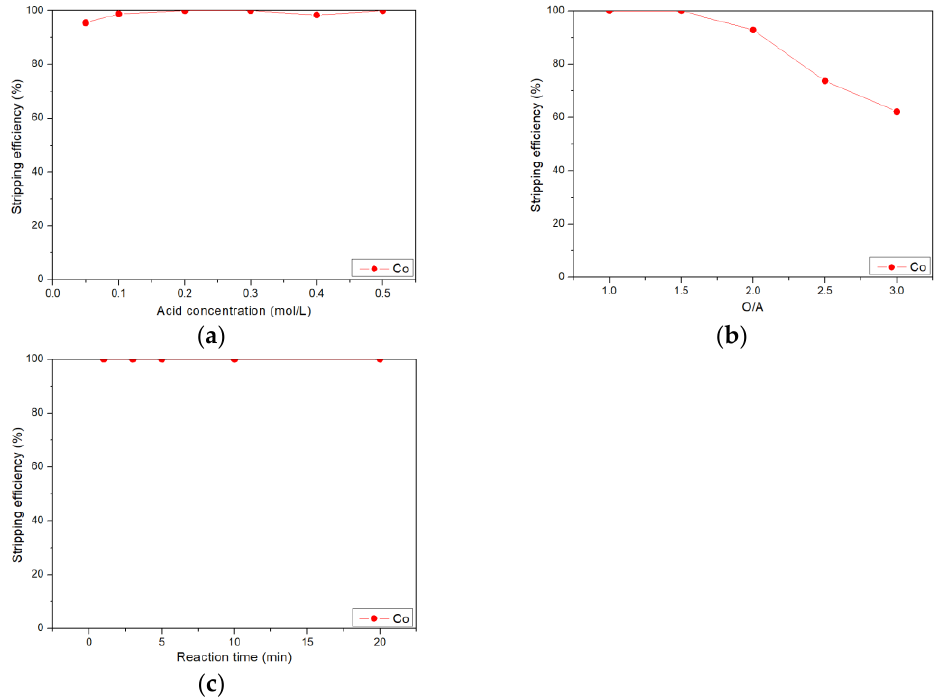
Figure 5. Effects of ( a ) acid concentration (O/A = 1, t = 15 min), ( b ) oil – water ratio ([H 2 SO 4 ] = 0.1 M, t = 15 min), and ( c ) reaction time ([H 2 SO 4 ] = 0.1 M, O/A = 1.5) on cobalt stripping.